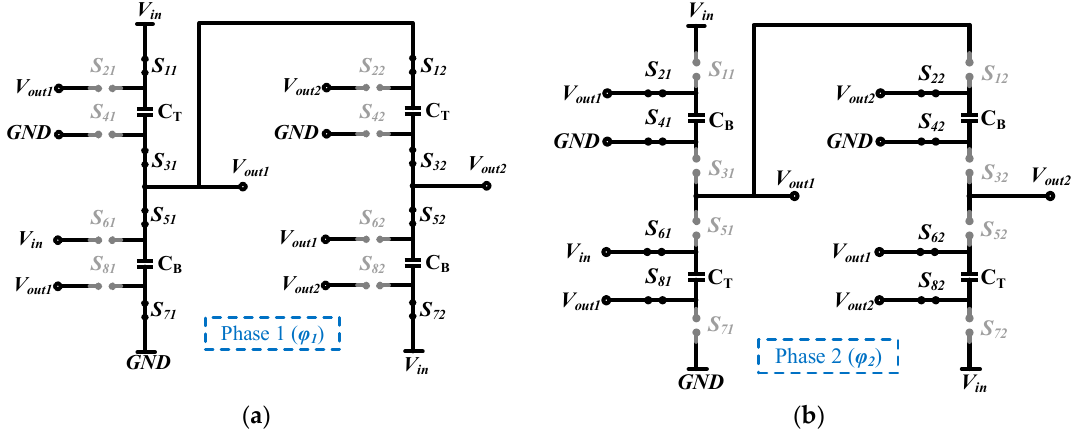
Figure 7. A small example of 2-bit SSC-DVS architecture with conversion ratios of 1 ( ϕ 1 ); and ( b ) phase 2 ( ϕ 2